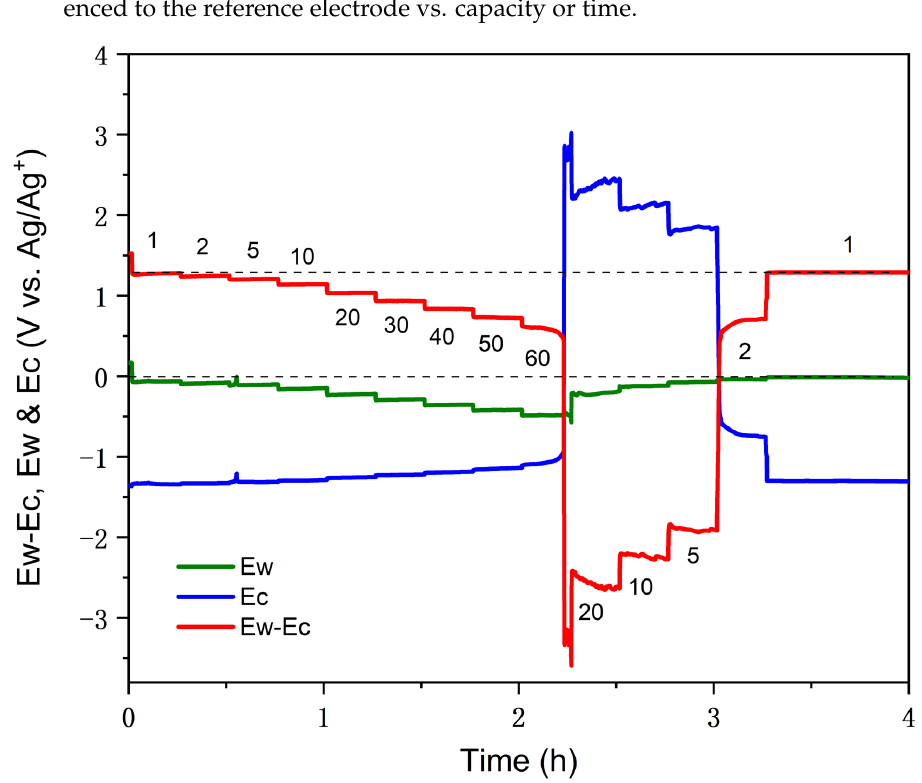
Figure 1. Voltage of the working (Ew), counter (Ec), and battery (Ew–Ec) curves versus time at different current density values for a Zn/air liquid battery. The working electrode was a commercial air electrode, and a Zn plate was the counter. Numbers included are the current density values. The pseudo-reference electrode was an Ag wire. Electrolyte: ~1 mL of 6 M KOH